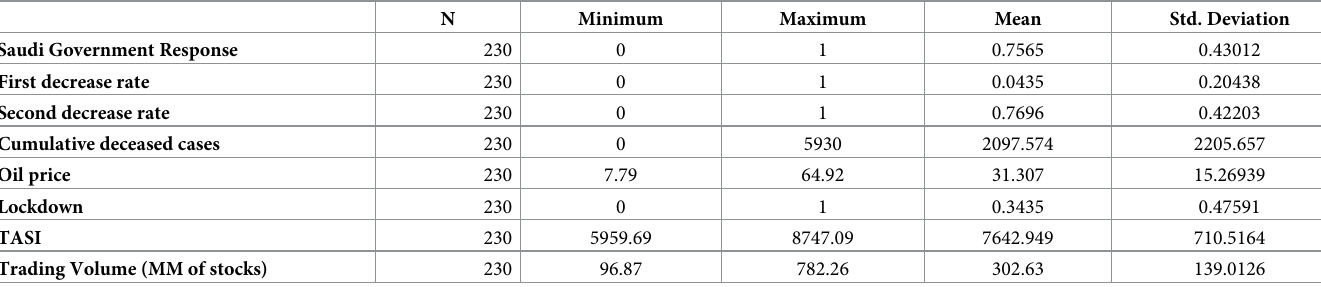
Table 1. Descriptive statistics of the independent and dependent